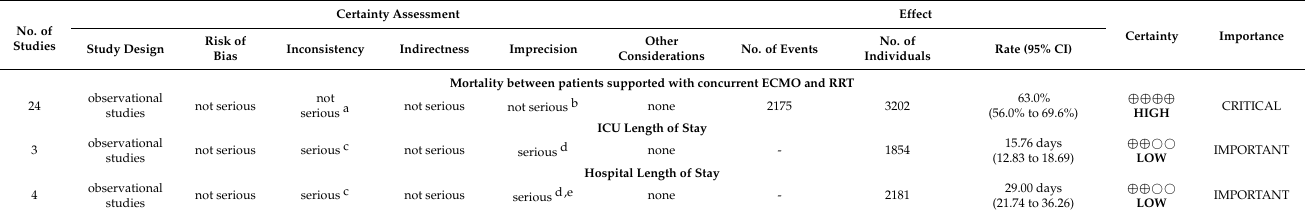
Table 3. Grading of Recommendations, Assessment, Development, and Evaluation (GRADE)